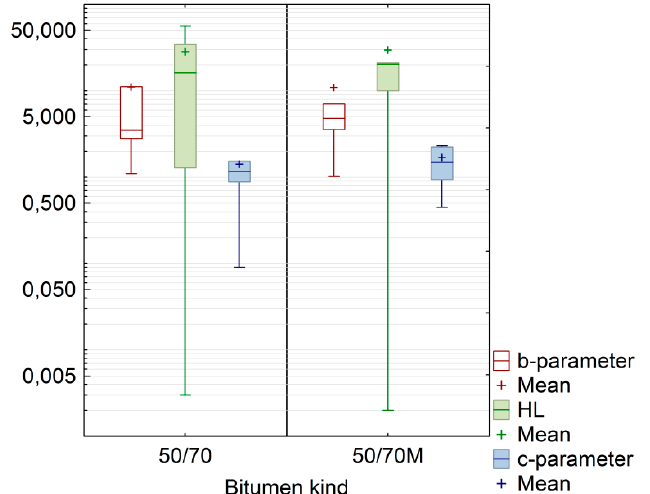
Figure 2. Box-and-whisker plot for the bitumen foam distribution parameters.